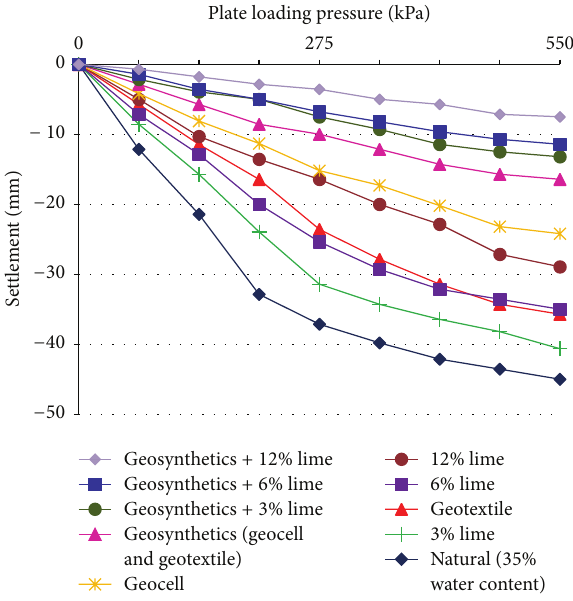
Figure 6: Loading-settlement